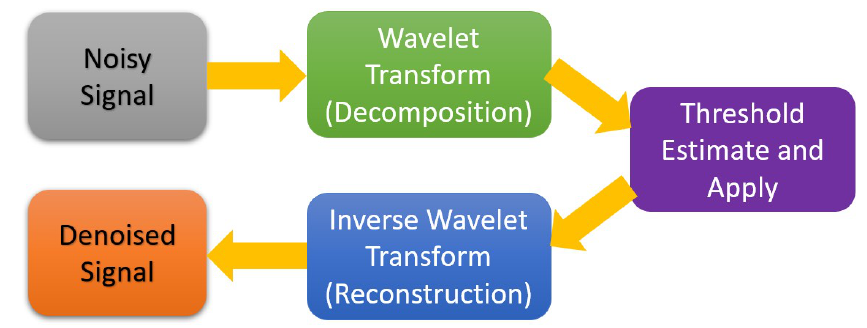
Figure 4. Basic steps in wavelet denoising.